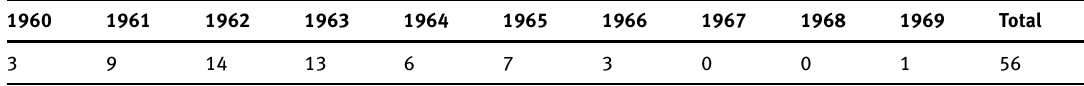
Table 1: Documented Instances of Violence-related Public Prayers, 1960-1969 1960